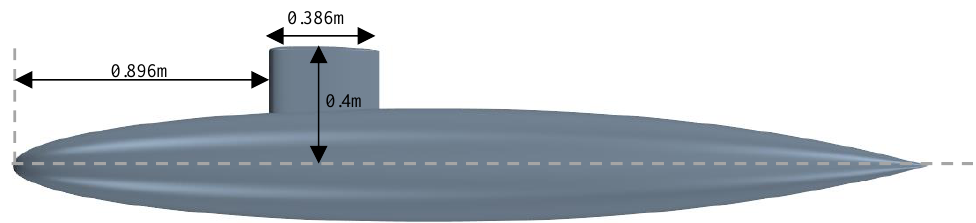
Figure 7. Geometry of underwater vehicle with sail.